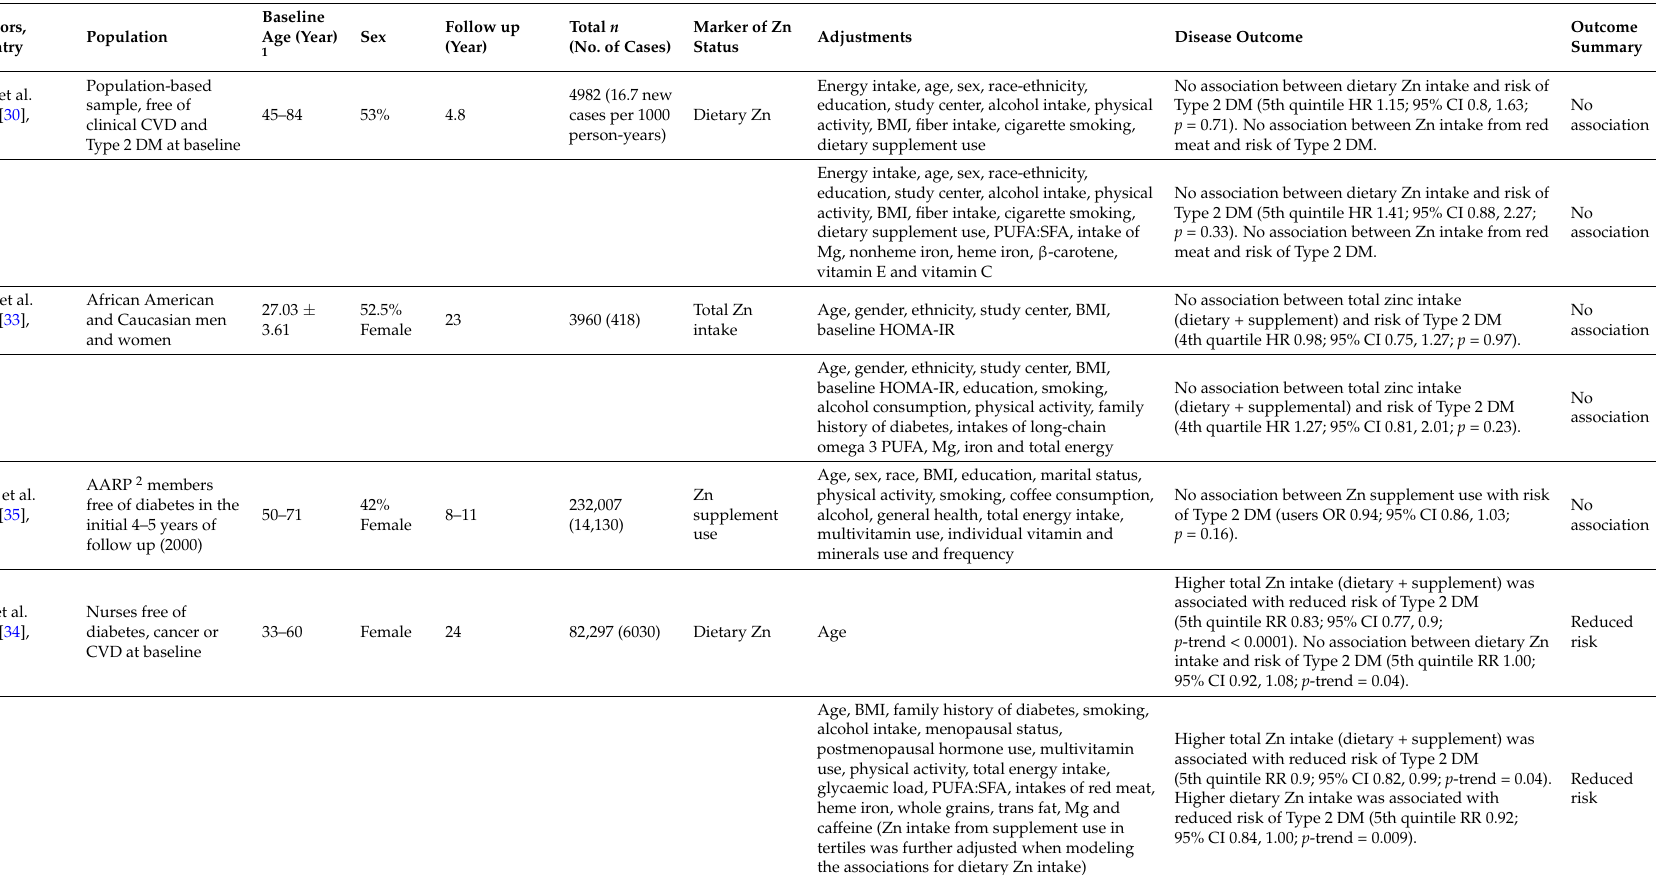
Table 3. Relationship between zinc status and risk of Type 2 diabetes mellitus in prospective cohort